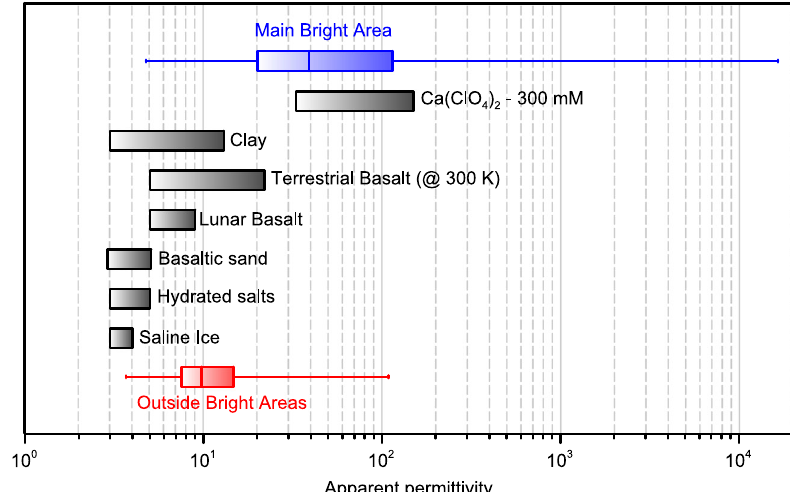
Fig.6|Apparentpermittivityofvariousmaterialscomparedtothoseretrieved by MARSIS at Ultimi Scopuli. The box plots indicate the basal apparent permit- tivityretrievedinsidethemainbrightarea(blue)andoutsidethebrightareas(red), where the whiskers represent the minimum and maximum values, the box extremes the lower and upper quartiles, and the center line the medianof the data